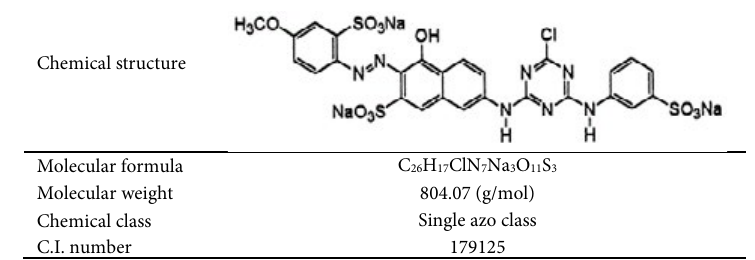
Table 1. Characteristics of Reactive Red 43